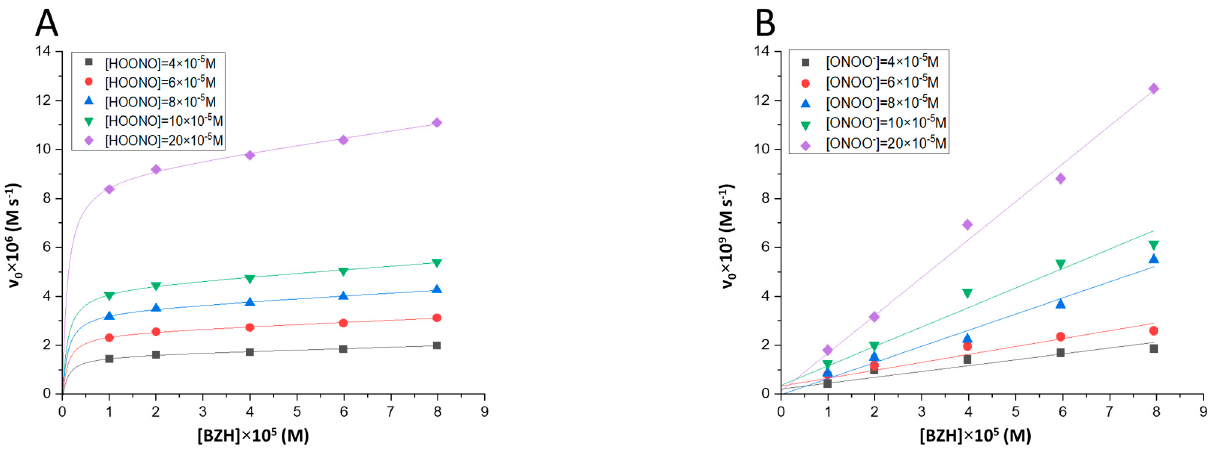
Figure 2. Influence of substrate concentrations on initial reaction rate. Experimental conditions: I = 0.1 M, T = 25 °C, ( A ) pH = 2, ( B ) pH= 11.2.